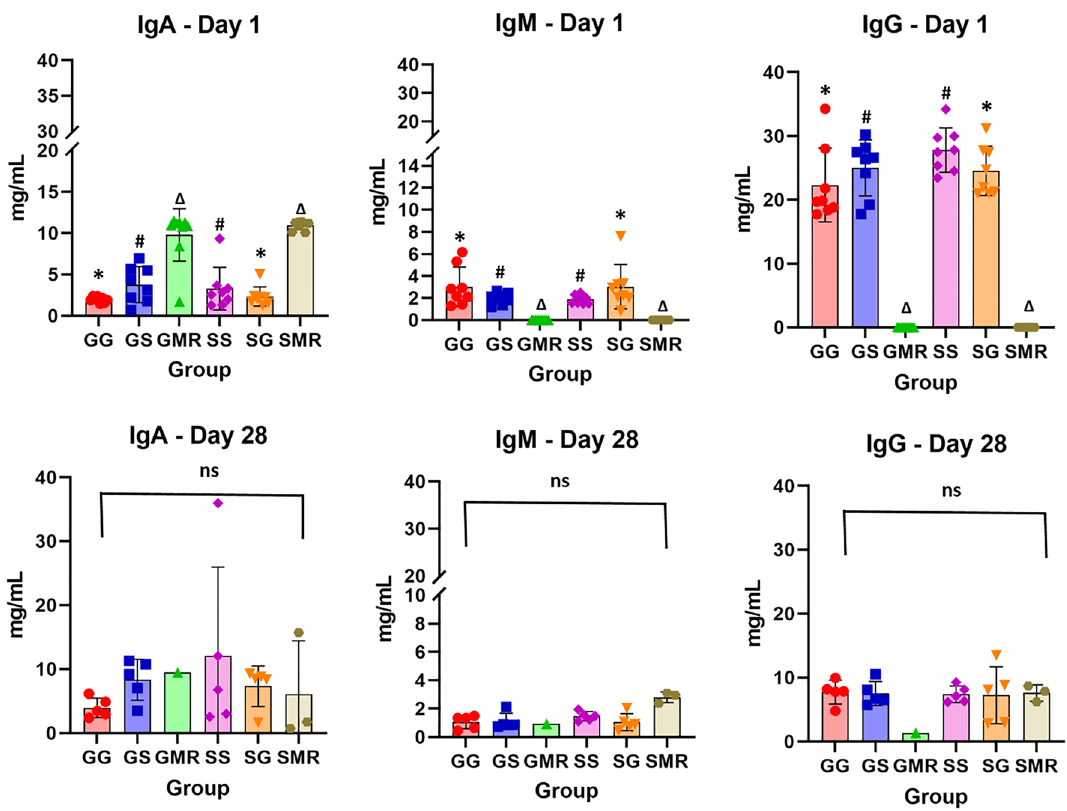
Figure 2. Effect of sow parity and their colostrum on piglet serum immunoglobulin concentration (mg/mL) at 24 h and 28 days after birth. Error bars represent the standard error of the mean (± SEM). Asterisks indicate significant differences among groups ( P ≤